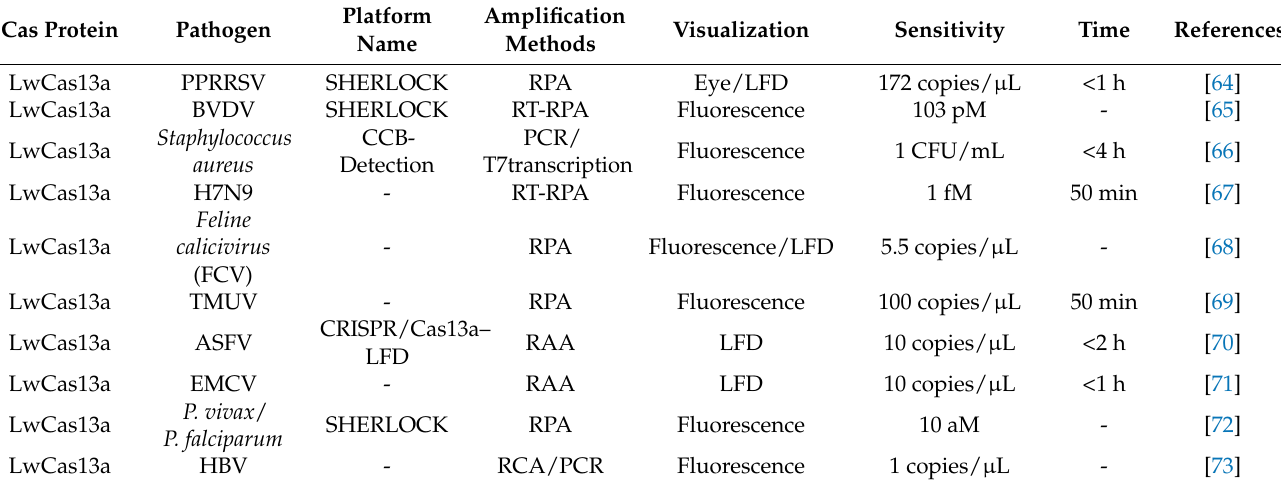
Figure 6. Complete SHERLOCK experimental workflow. The substrate DNA or RNA was first amplified by RPA or RT-RPA to increase the substrate concentration. Subsequently, T7 transcriptase transcribes the amplified DNA into RNA and mixes it with Cas13a–crRNA reaction solution. According to different reporters, lateral flow test strips or fluorescent signals can be selected as the output mode. Four Cas proteins with different cutting preferences can also be used for multiple detection. Table 3. More applications of CRISPR/Cas13a in pathogen detection.